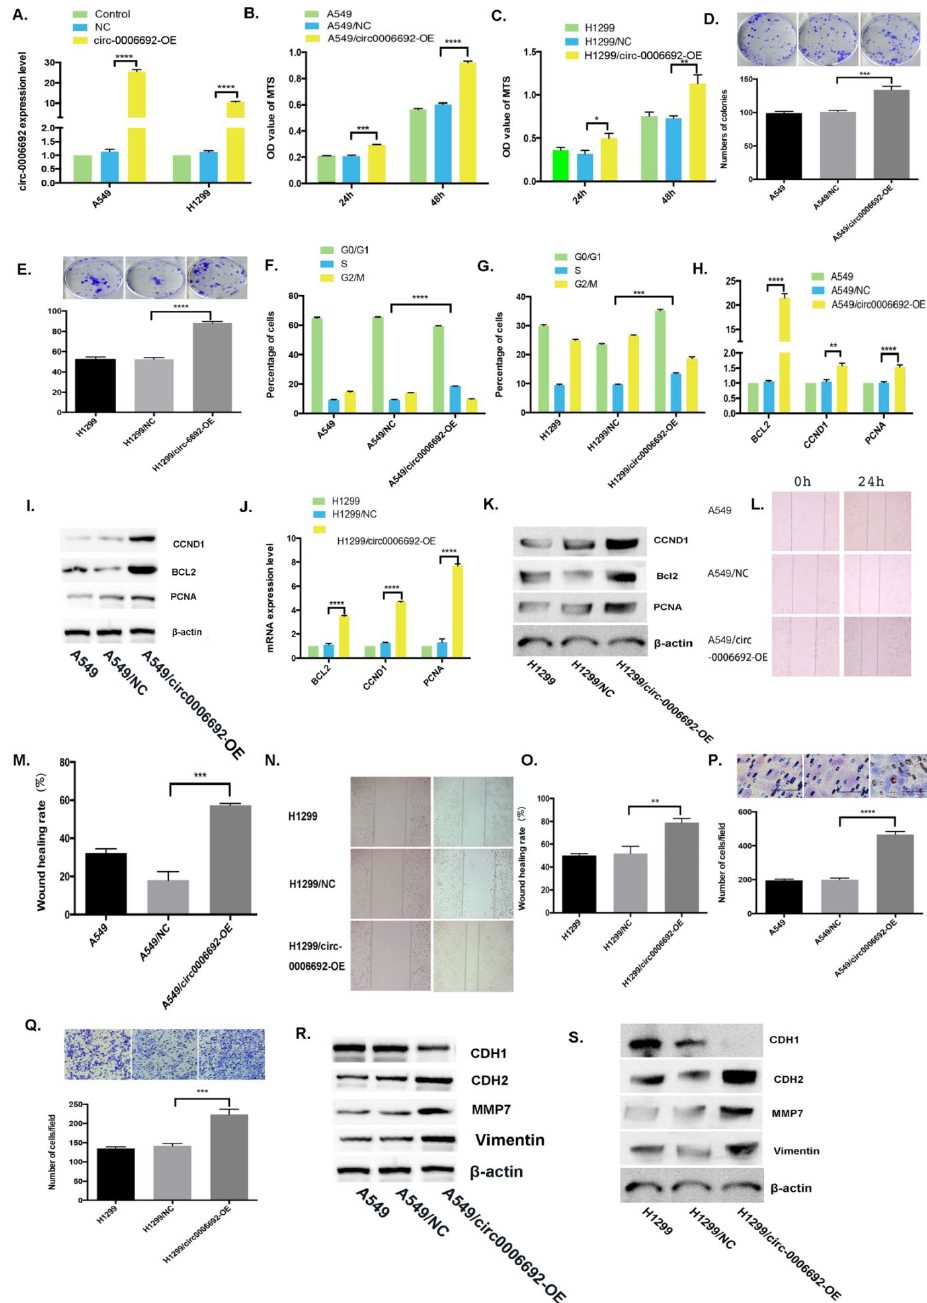
Figure 2. Over-expression of hsa_circ_0006692 promoted the proliferation, migration, and invasion of lung cancer cells. ( A ) qPCR on hsa_circ_0006692 expression in A549 and H1299 cells; ( B , C ) The roles of overexpressed hsa_circ_0006692 in the vitality of A549 and H1299 cells measured using the MTS assay; ( D , E )The roles of overexpressed hsa_circ_0006692 in the colony formation of A549 and H1299 cells; ( F , G ) The role of overexpressed hsa_circ_0006692 in cell cycle distribution of A549 and H1299 cells measured with FACS; ( L – O ) The role of overexpressed hsa_circ_0006692 in the migration of A549 and H1299 cells measured by the wound healing assay; ( P , Q ) The role of overexpressed hsa_circ_0006692 in the invasiveness of A549 and H1299 cells measured using the transwell invasive assay; ( H – K ) The expressions of proliferation-related-genes of Bcl-2 , CCND1, and PCNA were detected by qRT-PCR and WB; ( R , S ) The expression levels of invasion/metastasis-related-genes, MMP7 , VIMENTIN , CDH1 , and CDH2 demonstrated by WB. * p < 0.05; ** p < 0.01; *** p < 0.001; **** p <